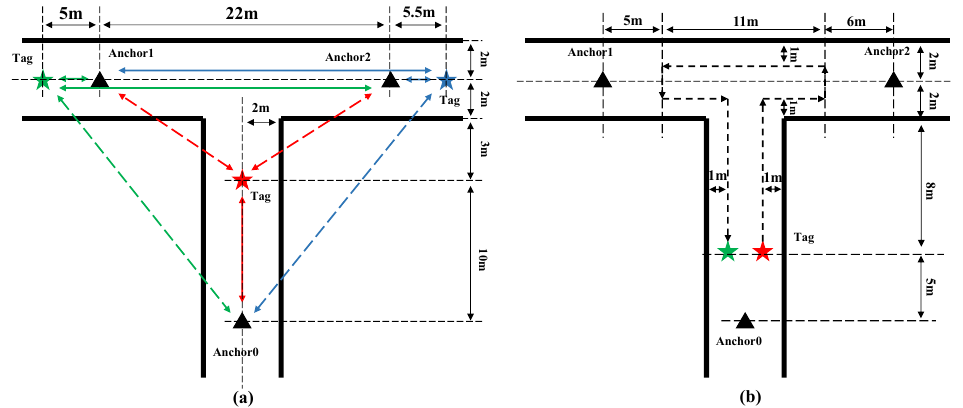
Figure 14. ( a , b ) are the concept diagrams of the static experiment and dynamic experiments, respec- tively. The black thick solid line indicates the boundary of the environment, and the five-pointed star indicates the position of the tag at different positions.